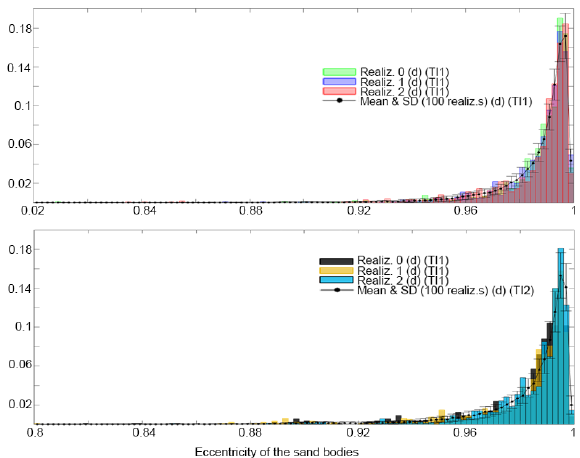
Figure A1. Sizes of the sand bodies for the realizations obtained by using the conditioning strategy in Table 1 and respectively (a) TI1 and (b) TI2 (Fig. 10). While the histograms correspond to the first three realizations, the dots and error bars represent the mean and the standard deviation obtained by using 100 realizations.